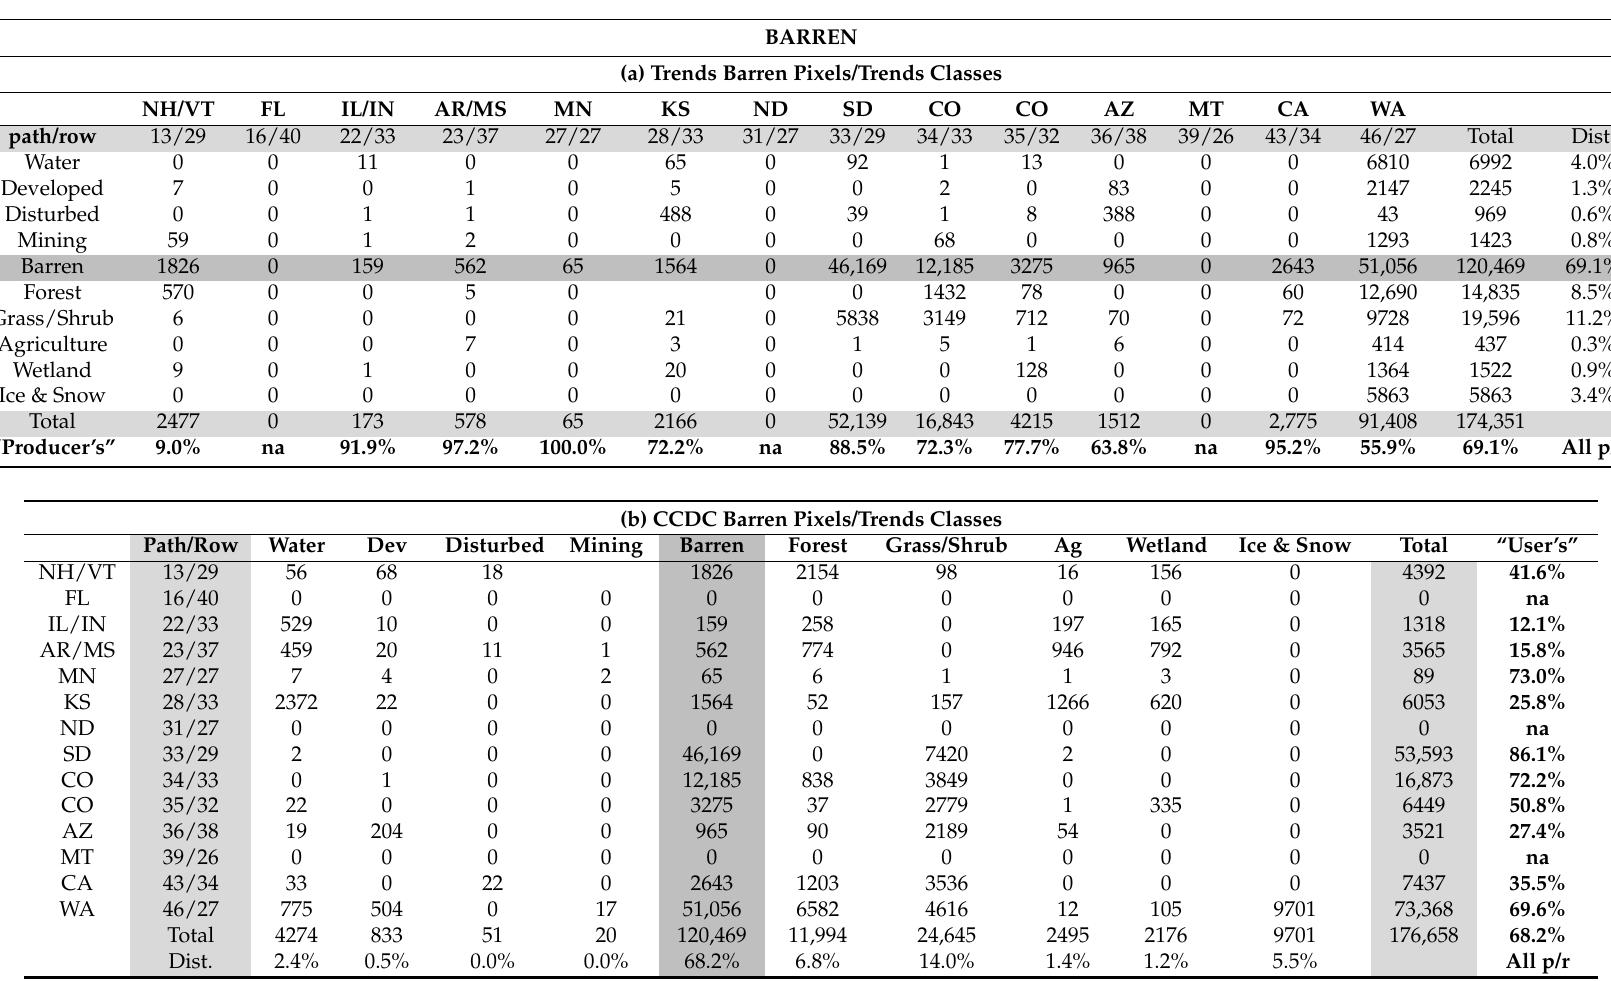
Table 11. (a) LC Trends Barren pixels distributed across CCDC classes for each path/row location and (b) CCDC Barren pixels distributed across LC Trends classes for each path/row. AR = Arkansas; AZ = Arizona; CA = California; CO = Colorado; FL = Florida; IL = Illinois; IN = Indiana; KS = Kansas; MN =